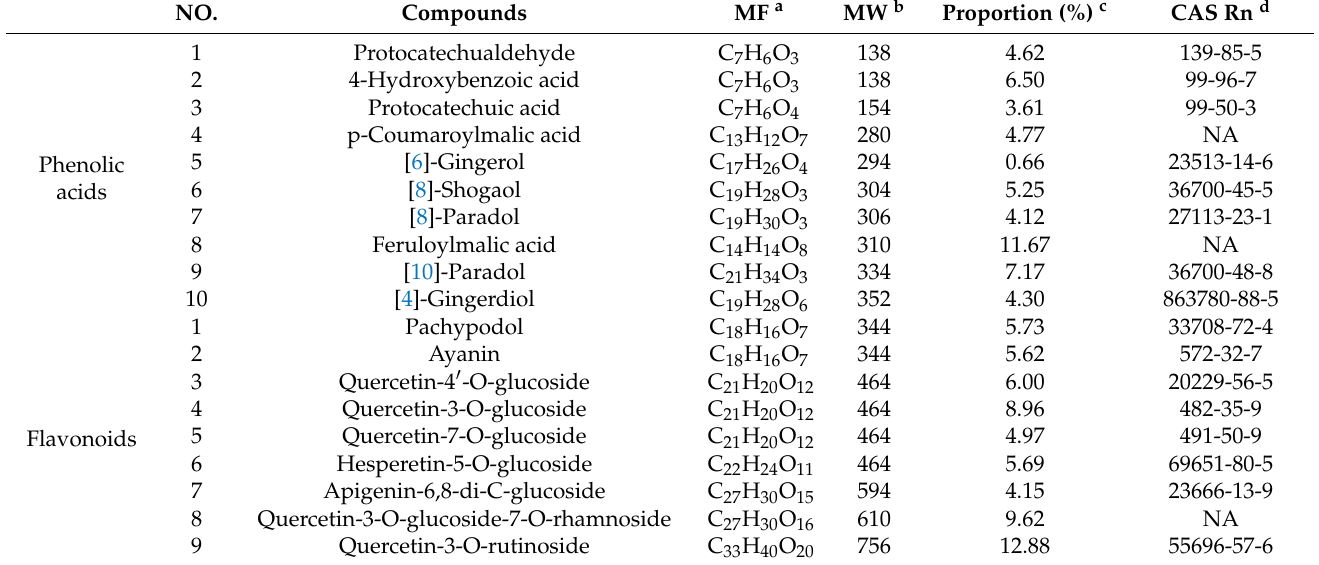
Table 2. The two principal components (phenolic acids and flavonoids) in GSE were deeply explored, and the main properties and contents of their secondary metabolites were analyzed.